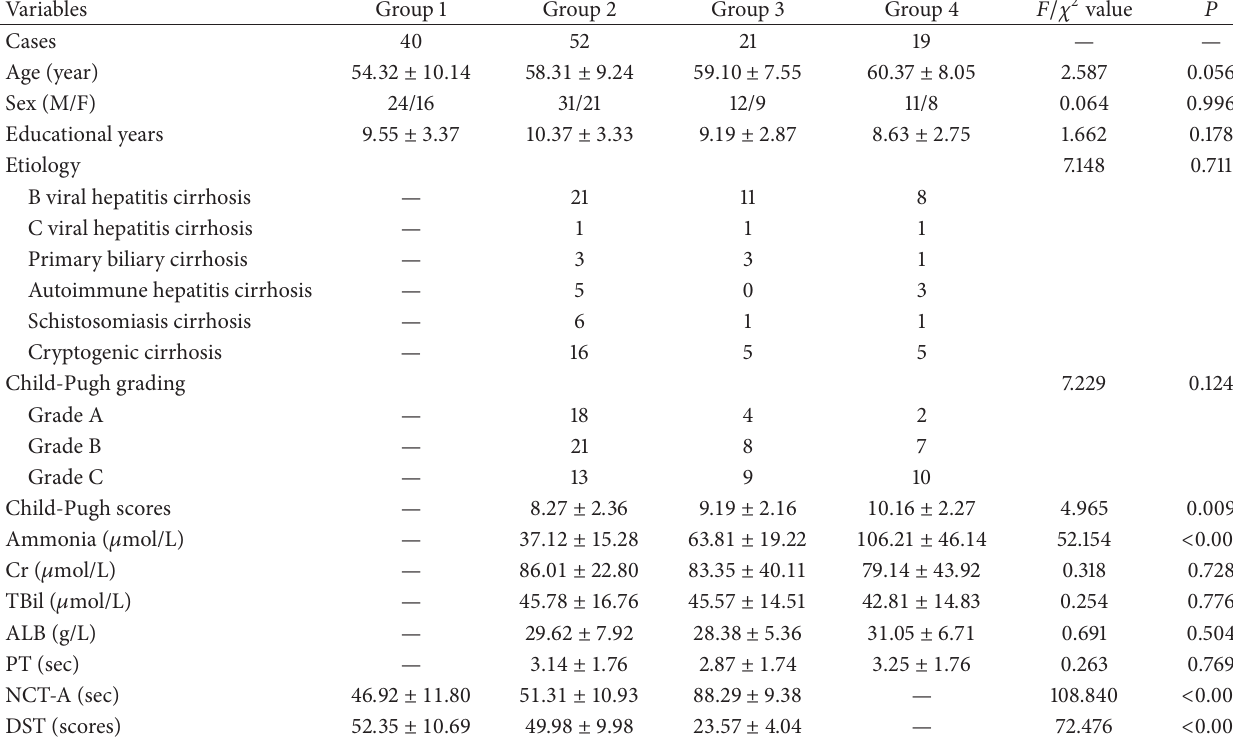
Table 2 indicates comparison of age, sex, educational years, etiology, Child-Pugh grading, Child-Pugh scores, ammonia, Cr, TBil, ALB, PT, NCT-A, and DST among groups 1, 2, 3, and 4 before treatment. Group 1 is healthy controls group, group 2 is cirrhosis without HE group, group 3 is cirrhosis with MHE group, and group 4 is cirrhosis with OHE group. Continuous data were compared using ANOVA and categorical data were compared by a chi-square test. 𝑃 < 0.05 means significant differences in an index among